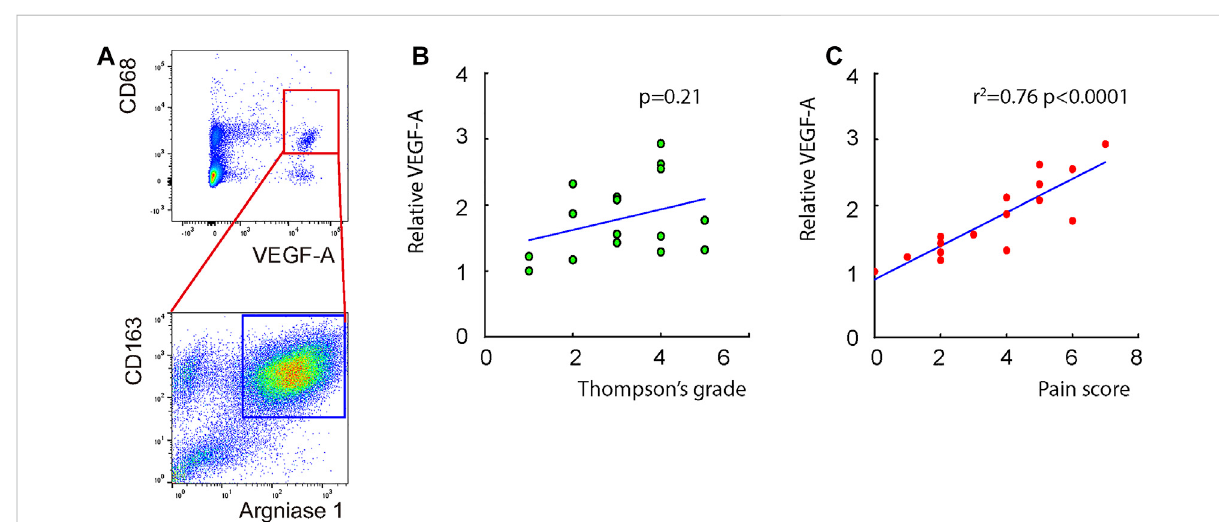
statistic test (Figure 2C) and mean-variance trend (Figure 2D). We detected some differential genes upregulated or downregulated in LDD, compared to controls (Figure 2E). Interestingly, KEGG pathway analysis showed that VEGF-A signaling pathway was a major altered one (Figure 2F). Thus,